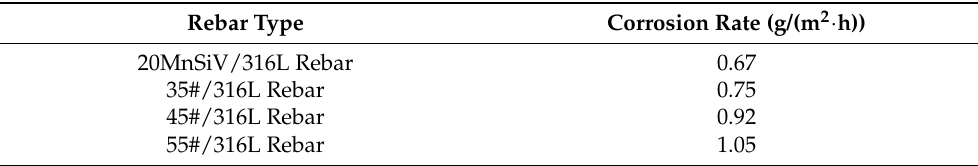
Table 7. Calculated corrosion rates of the various rebars.